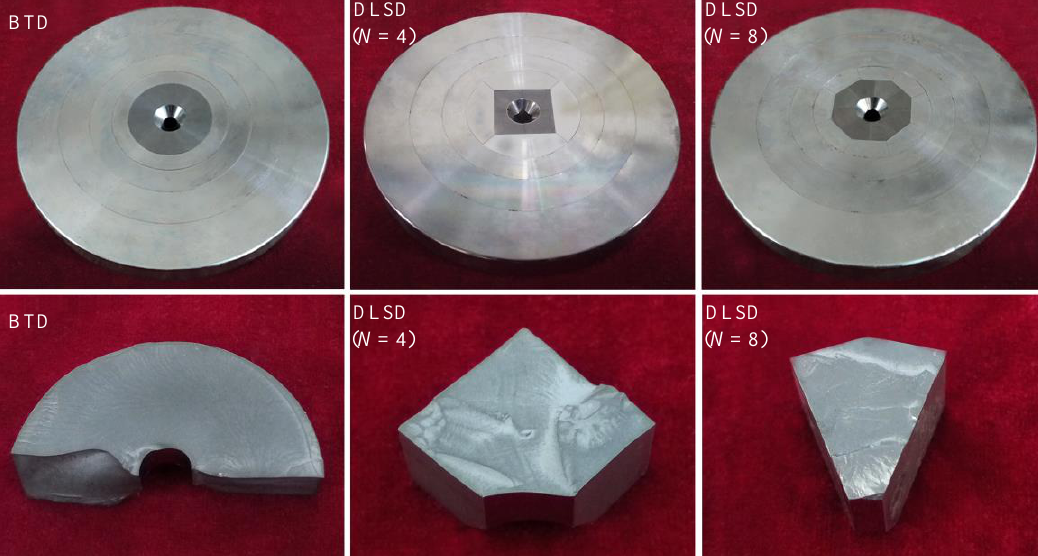
Figure 12. Assembled BTD and DLSD with 4 and 8 split blocks as well as the corresponding cracked cylinders.